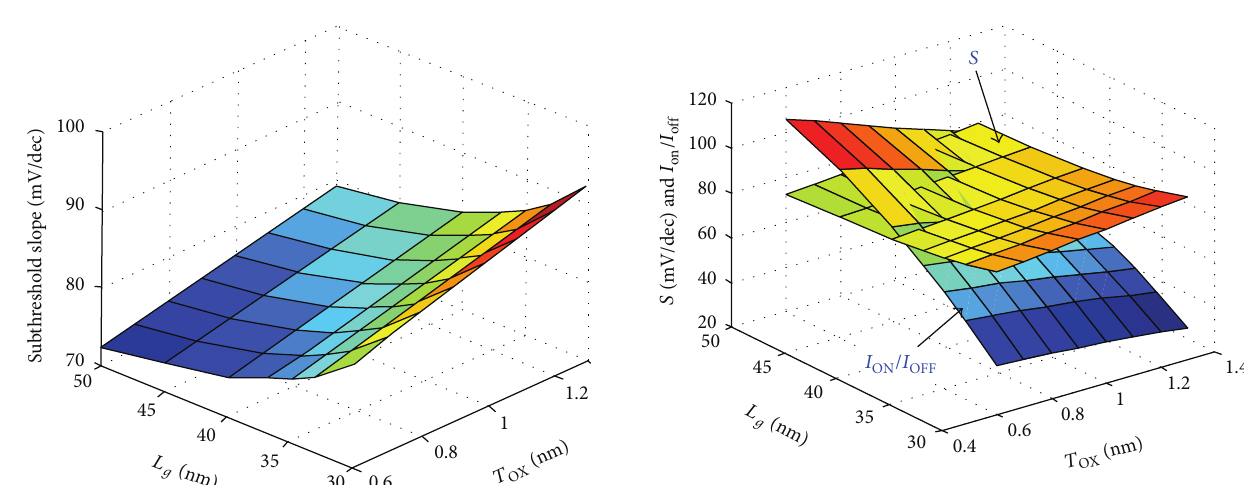
Figure 8: Subthreshold slope and 𝐼 ON /𝐼 OFF as a function of 𝐿 𝑔 and 𝑇 OX for 45 nm